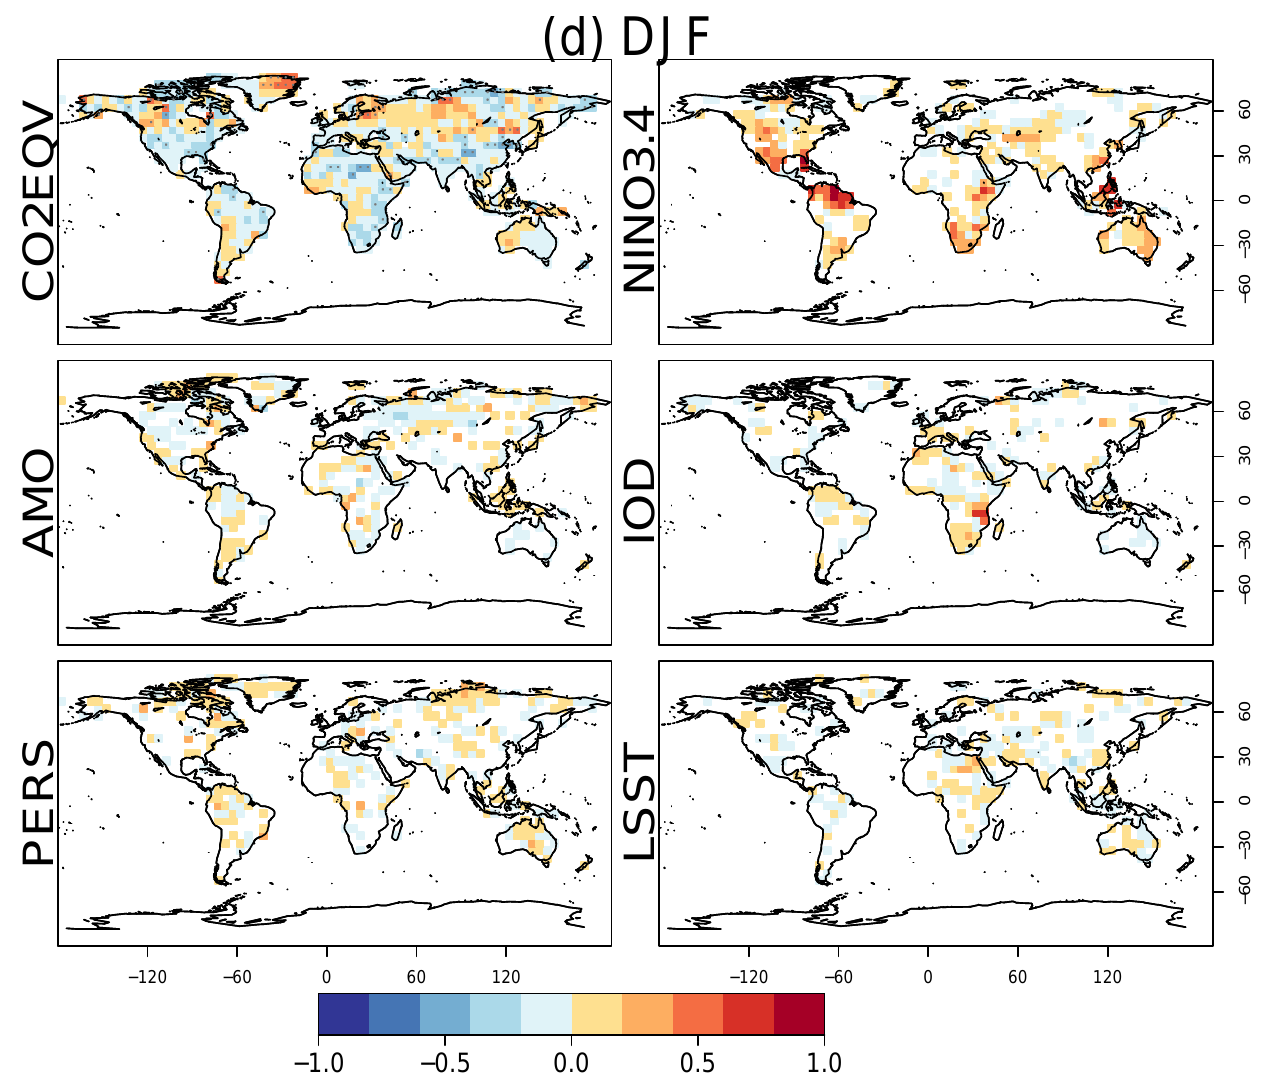
Figure 6. Correlation between PREC hindcasts and observations (1961–2013) for (a) MAM, (b) JJA, (c) SON, and (d) DJF. The top left panel shows correlation between observations and SAT hindcasts constructed using the CO 2 equivalent as the sole predictor; stippling is used to indicate significance at the 95% level. Subsequent panels show difference in correlation following the inclusion of additional